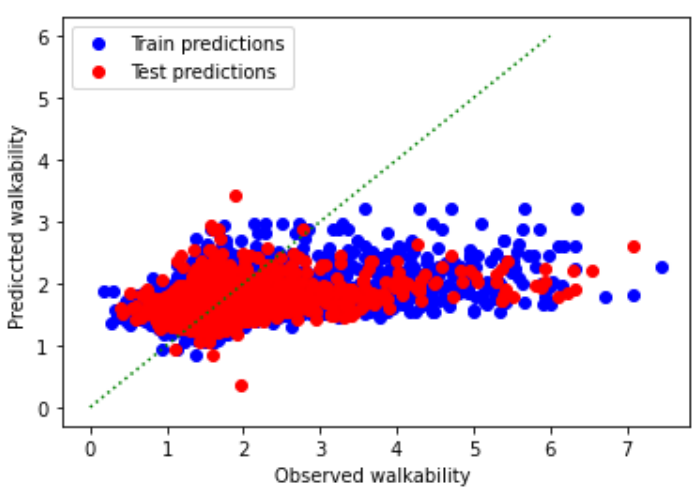
Figure 6: Error plot showing the error of the model between observed walkability and walkability predicted by our model for the obtained